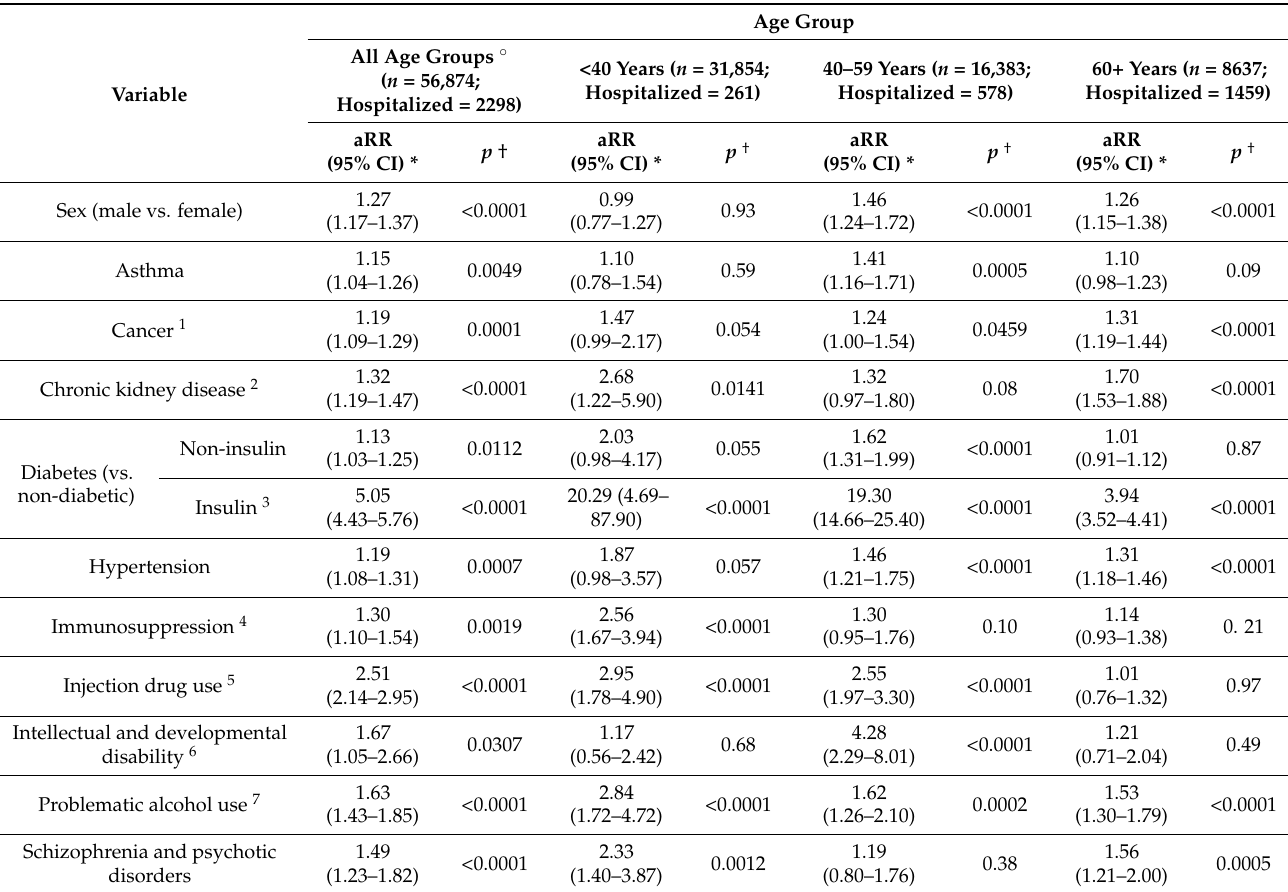
* Incidence rate ratios adjusted for the variables present in the table. ◦ Adjusted for also for age (as categorical groups from Table 2; not shown). † Wald’s test. 1 Assessed via “lymphoma”, “metastatic cancer” and “solid tumor without metastasis” ICD-9/ICD-10 codes from groups 18, 19 and 20 of Elixhauser Comorbidity Score in DAD, MSP and NACRS records. 2 Assessed via “renal disease” ICD-9/ICD-10 codes from group 14 of Elixhauser Comorbidity Score in DAD, MSP and NACRS records. 3 Any type; includes concomitant treatment